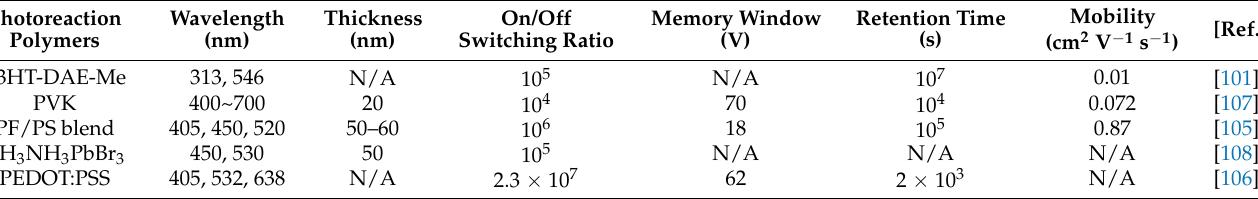
Table 5. Optoelectrical Memory characteristics